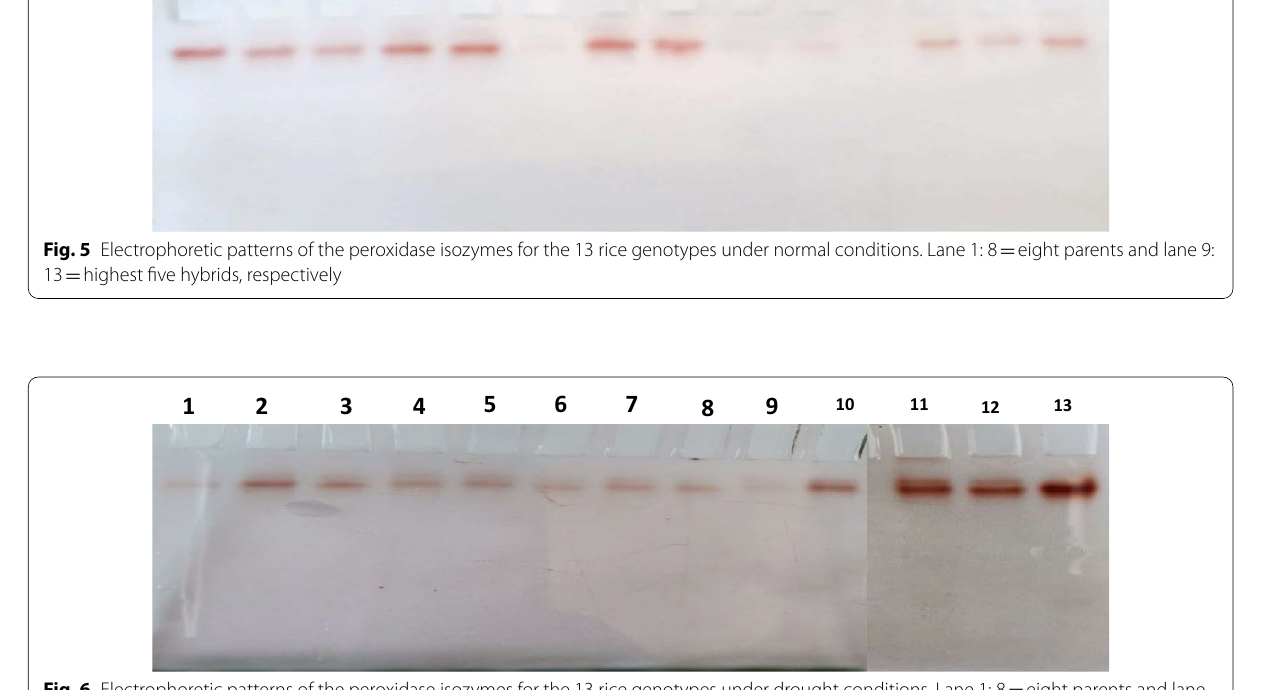
eight parents and lane =